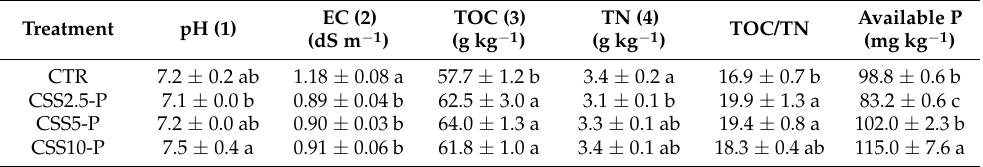
Table 2. Chemical properties determined on soil samples after the addition of a different